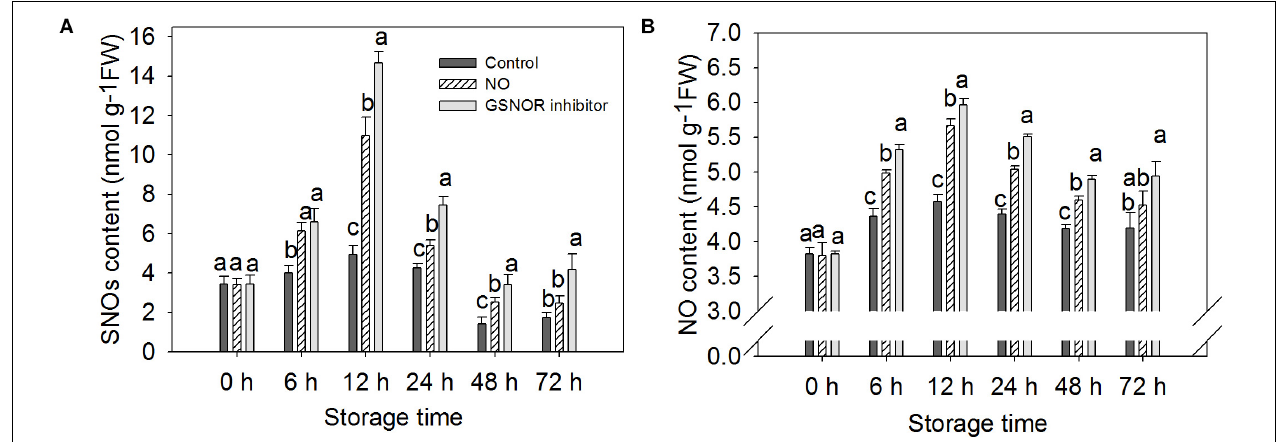
FIGURE 4 | Effect of nitric oxide (NO) or S -nitrosoglutathione reductase (GSNOR) inhibitor treatment on the content of (A) SNOs and (B) NO of peach fruit storage at 23 ◦ C. Vertical bars represent the standard deviation of the means ( n = 6). Different letters represent significant differences ( P < 0.05) according to least significant difference (LSD)